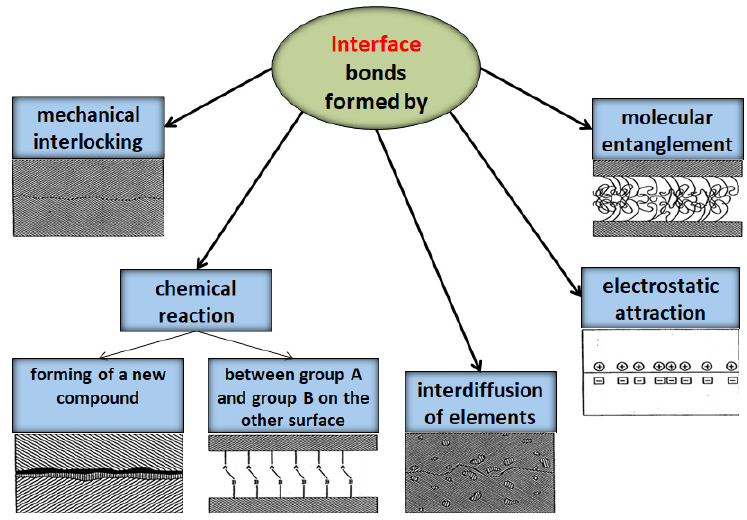
Figure 2. The formation of the interface between matrix and filler.